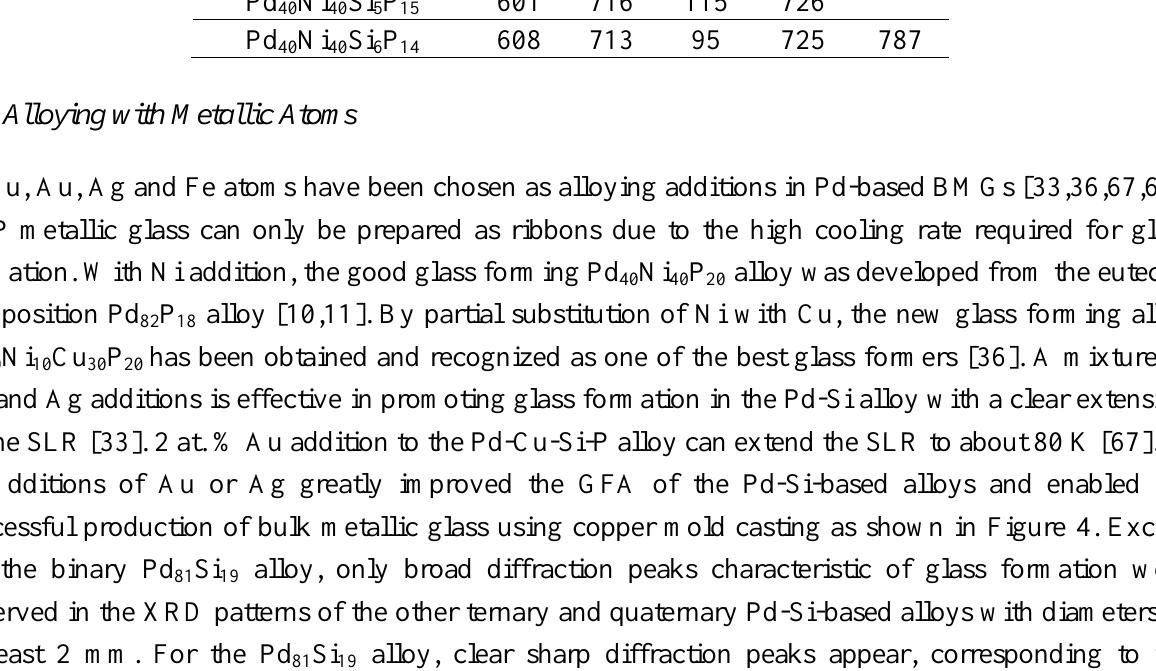
Table 3. Thermodynamic and kinetic parameters and plasticity of Pd (x = 0–6) and Pd